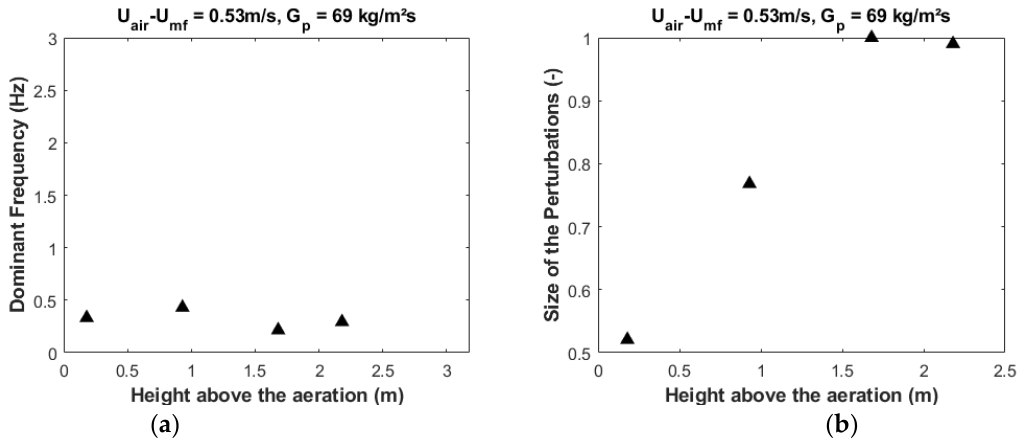
Figure 12. Evolutions with the height of ( a ) the dominant frequency of the IOP spectrum and ( b ) the integral of the IOP spectrum, for the same experimental configuration as for Figure 11.